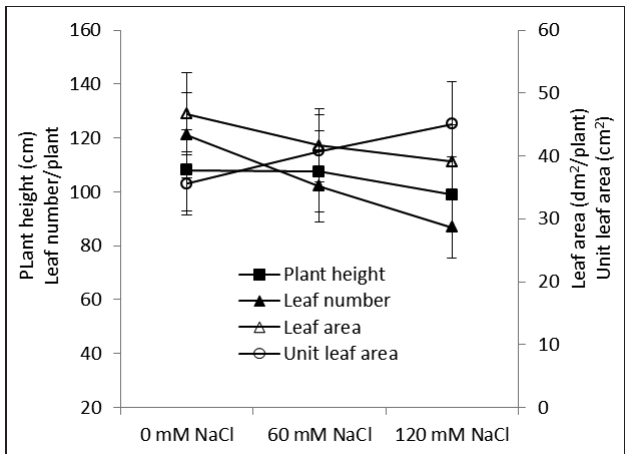
Fig. 2: Effect of NaCl on plant height, leaf number, leaf area and unit leaf area of cape gooseberry at 75 DAT. Bars indicate